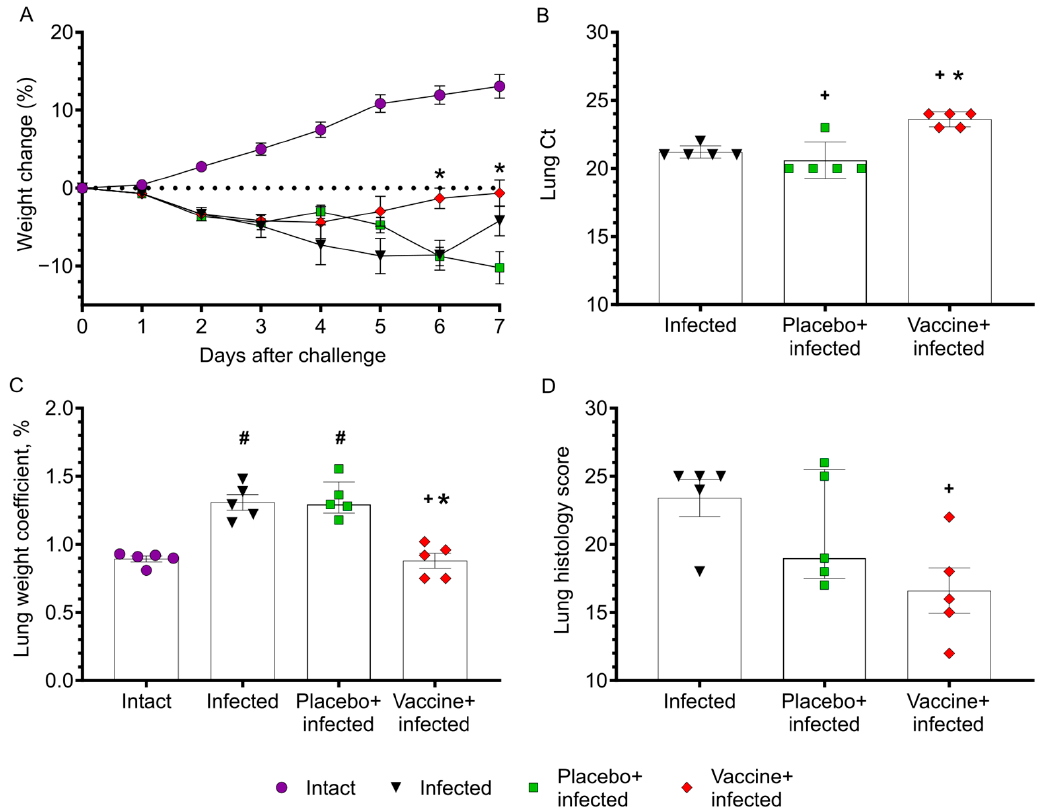
Figure 4. Protective e ff ects of Convacell ® in a Syrian hamster model. ( A ) Hamster body weight changes after SARS-CoV-2 challenge, M ± SEM. ( B ) Virus RNA quanti fi cation results presented as a Ct RT-PCR parameter, M ± SEM. ( C ) Lung weight coe ffi cient, M ± SEM. ( D ) Sum of lung histology score (see Table S2 for details of score rubric), Me(Q1;Q3). Statistically signi fi cant di ff erences ( p < 0.05) according to the Mann–Whitney test with two-stage step-up are indicated: (cid:31)#’ when compared to Intact group; (cid:31)+’ when compared to Infected group; (cid:31)*’ when compared to placebo-treated + in-